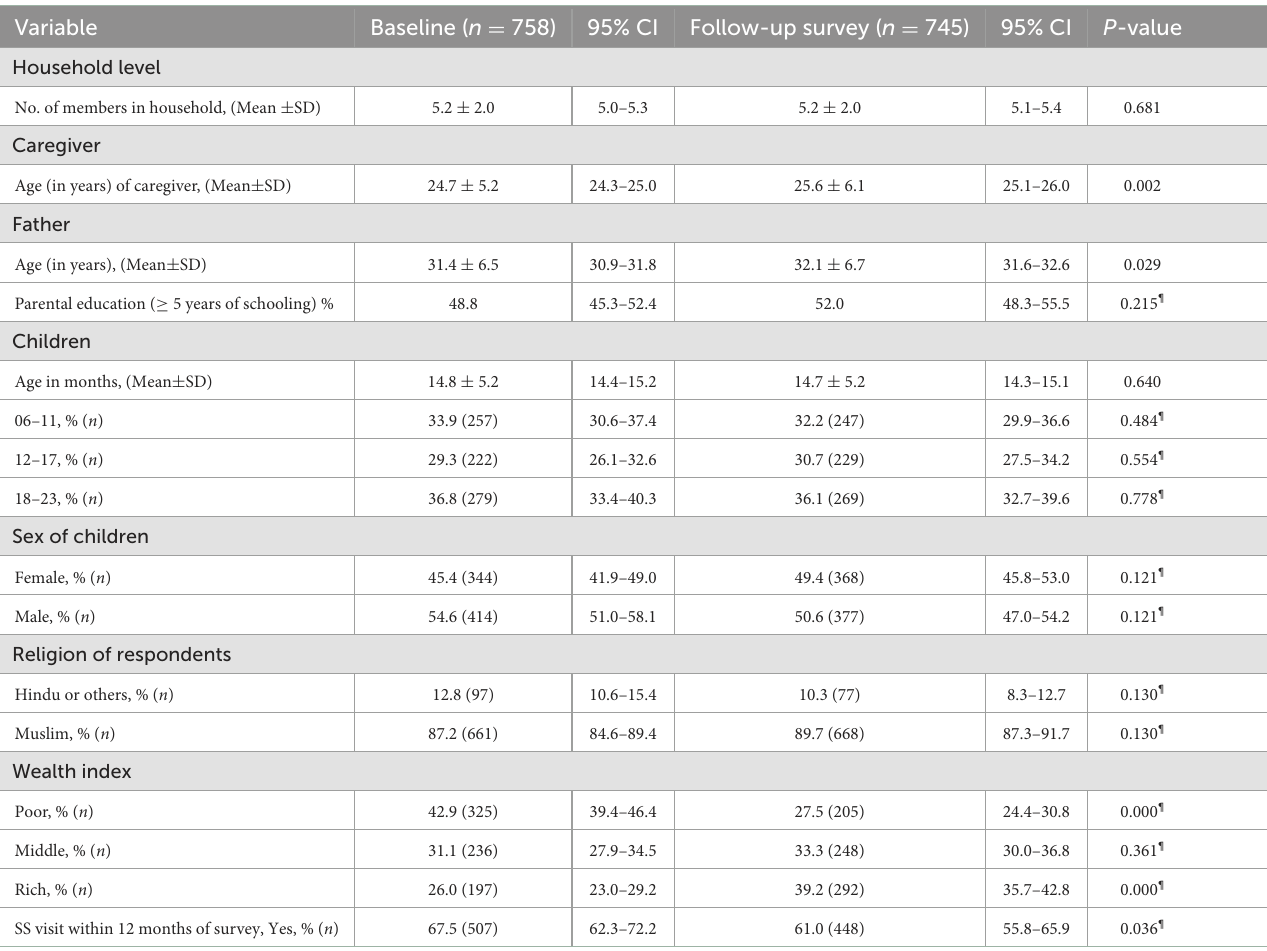
TABLE 2 Socio-demographic characteristics of the study participants. Variable Household